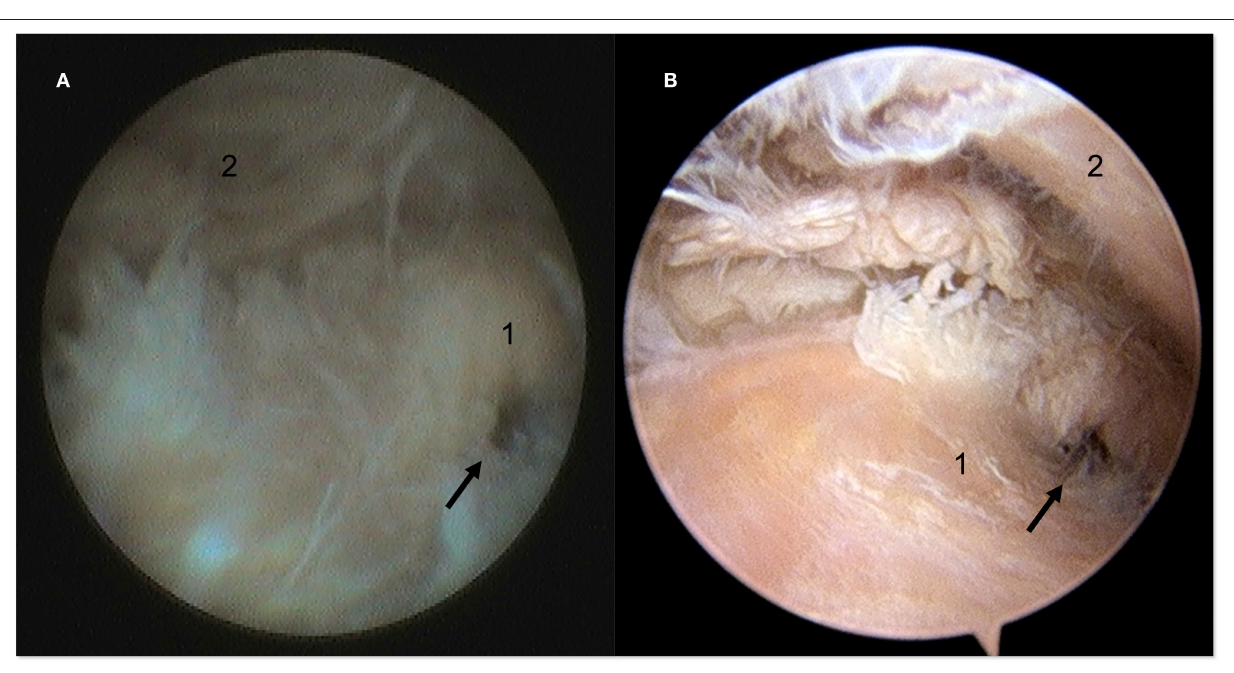
FIGURE 4 | Still arthroscopic image of the caudomedial aspect of the DTJ using the NAS (A) and the STAN (B) . A perforation (black arrow) in the intra-articular disc was identified at the caudomedial fibrous expansion (cfe) with both modalities. 1, intra-articular disc; 2, articular eminence of the temporal